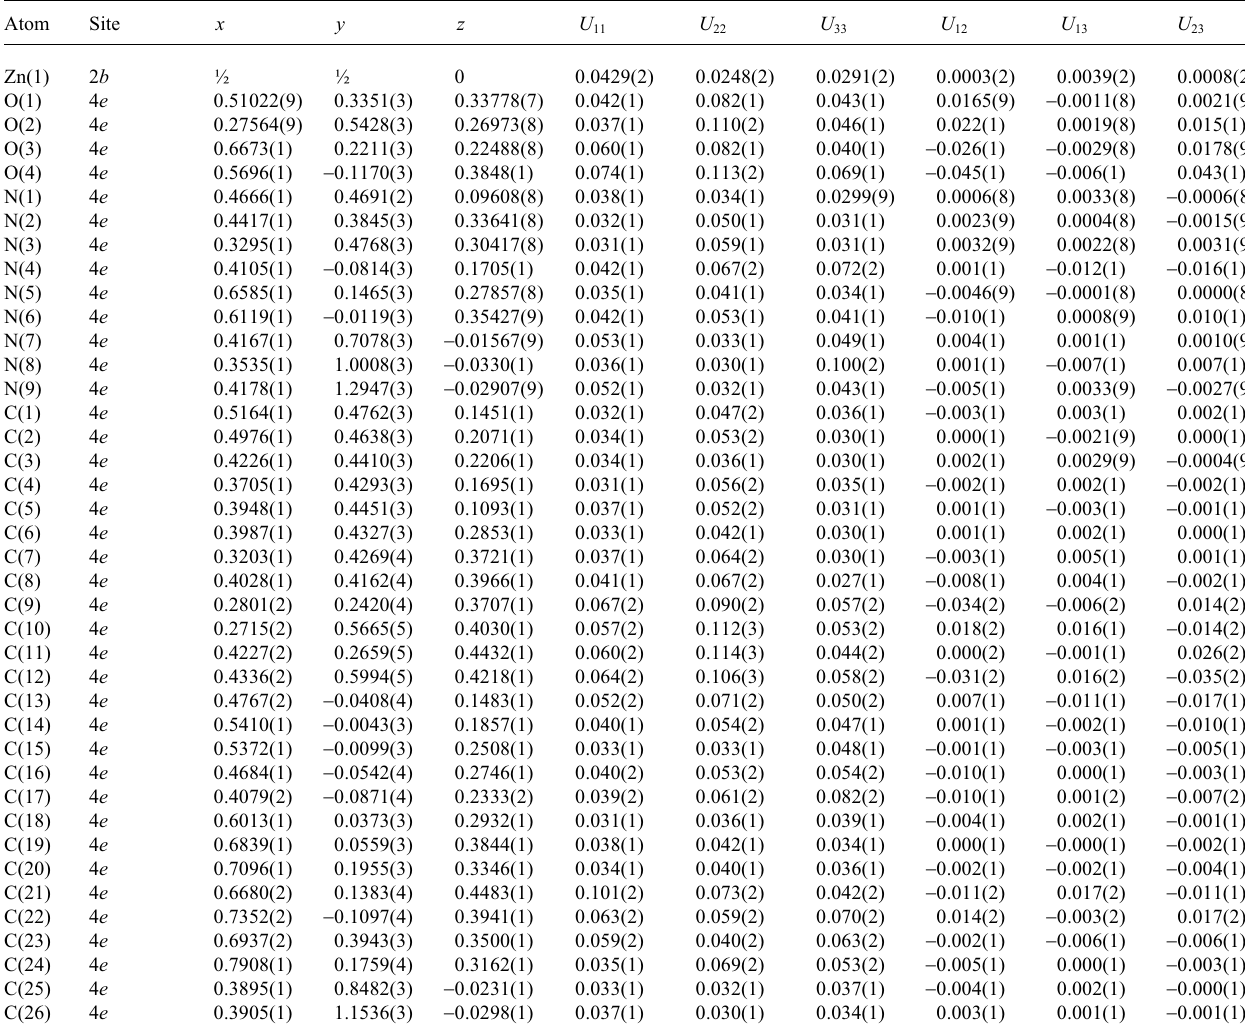
Table 3. Atomic coordinates and displacement parameters (in Å 2